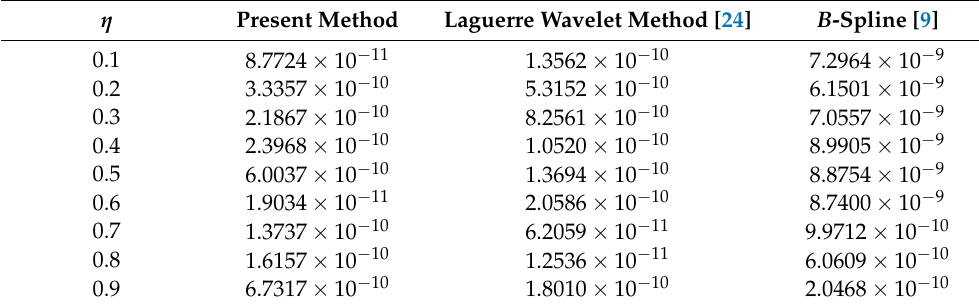
Table 6. Comparison of the proposed method’s absolute error with the HWM and B -spline methods of Example 2 for ζ =